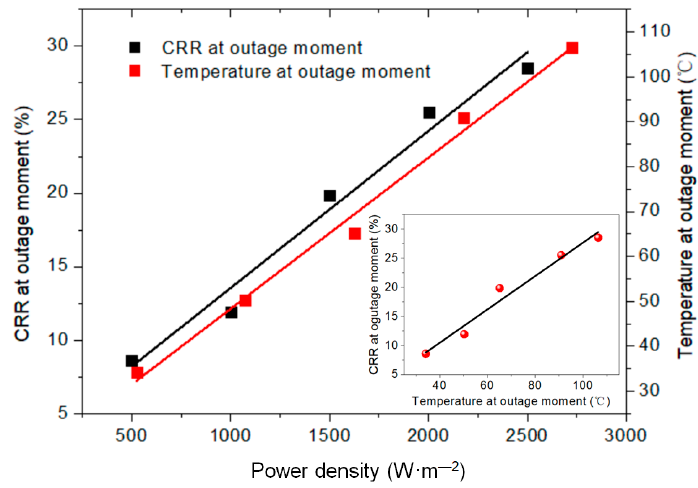
Figure 16. Relation among power density, CRR and temperature at outage moment for the 8 g·m − 2 membrane.